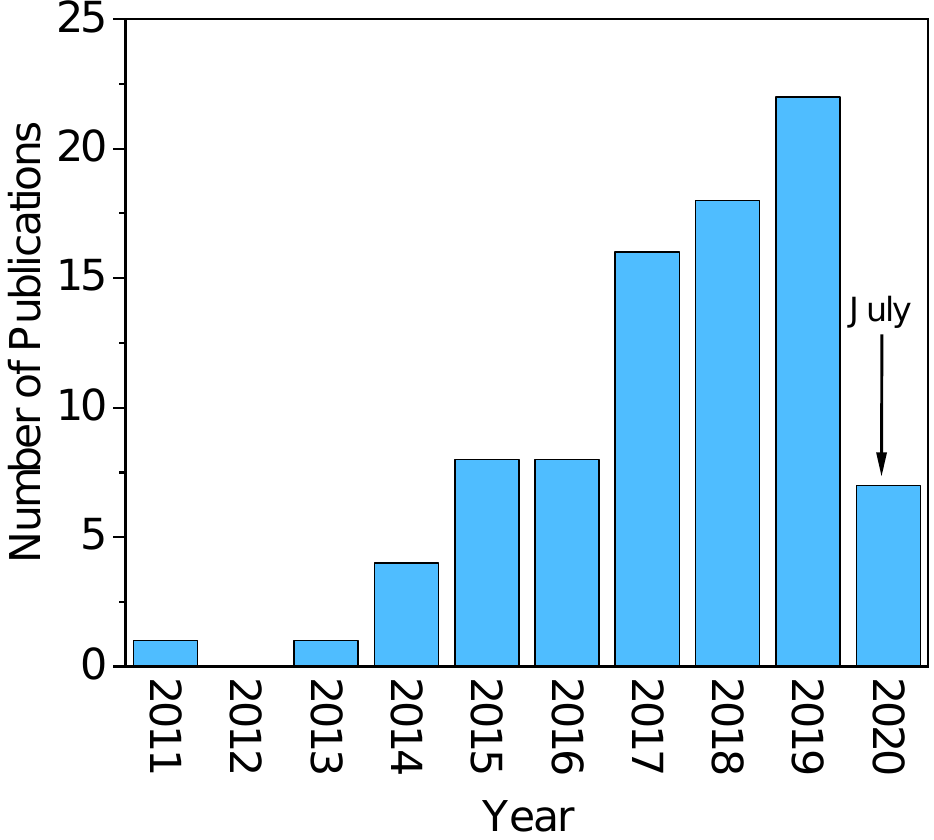
Figure 7. The number of publications that discuss the serrated-flow phenomenon in high-entropy alloys for years ranging from 2011 to July 2020, as determined from the Web of Science publication